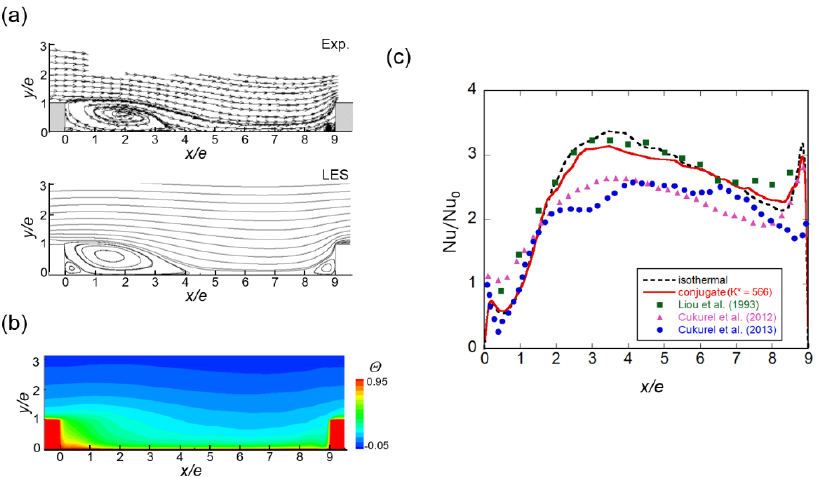
Figure 2. Time-averaged flow and thermal fields for the isothermal wall: ( a ) comparison of time- averaged streamlines with particle image velocimetry measurement data of Casarsa et al. [40], ( b ) the time-averaged temperature field, and ( c ) the Nusselt number ratio on the channel wall between ribs.